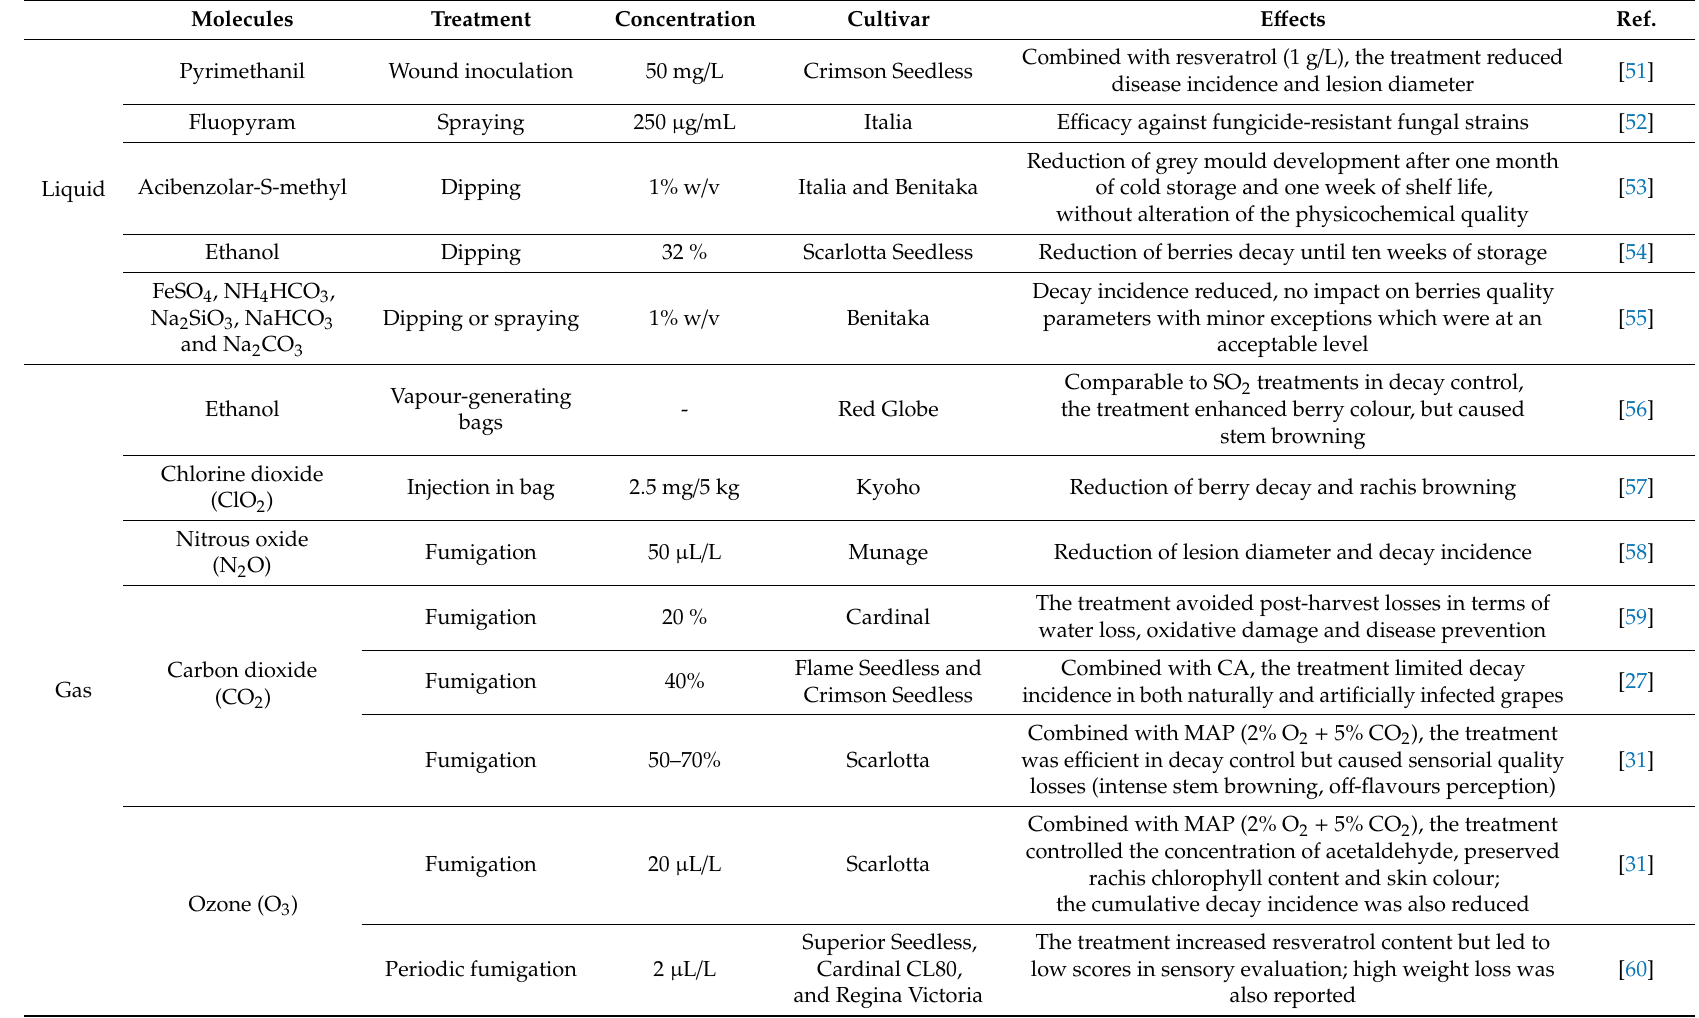
Table 2. Main chemical methods investigated in the last ten years against grey mould decay in table grapes.